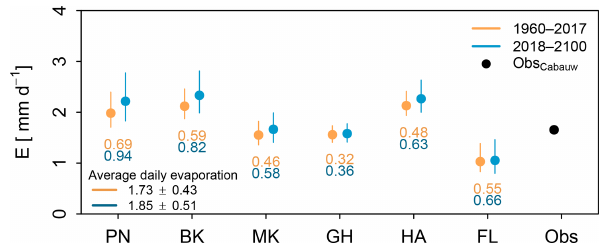
Figure 6. Impact of parameterization on mean current and future evaporation. Coloured dots indicate the mean of all RACMO mem- bers for each method for both the historical and future periods. Coloured numbers below each method indicate the spread within the method. Here spread within the methods is defined as the dif- ference between the average maximum and minimum values of all RACMO members for both periods, based on yearly average daily evaporation rates (see Fig. 5). The black dot represents the averaged observed evaporation in Cabauw over the period 1986–2017.